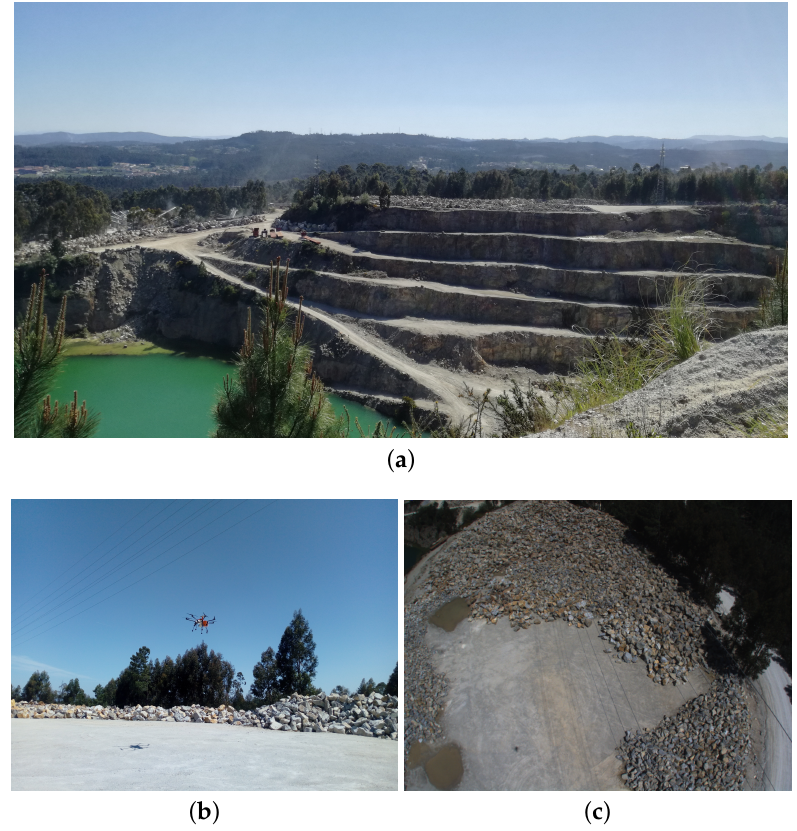
Figure 10. ( a ) Malaposta quarry overview; ( b ) STORK UAV mapping the stockpile; and ( c ) STORK UAV onboard